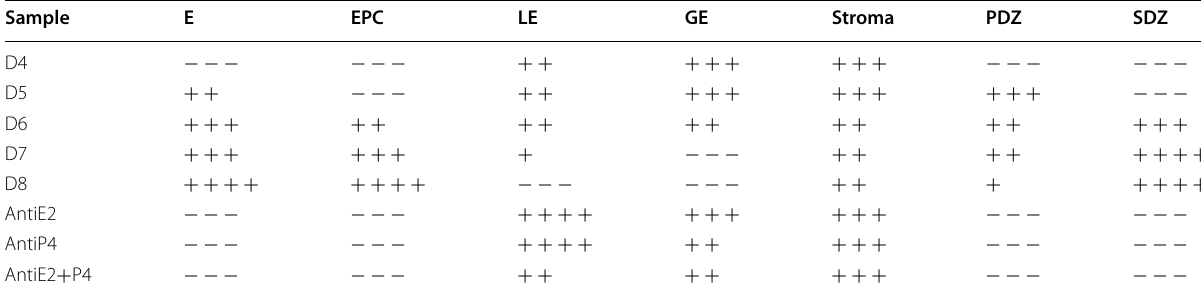
Table 2 Compartment specific expression profile of KLF5 during D4–D8 of gestation and in AntiE2-, AntiP4-, and AntiE2 females. Samples of ovarian steroid antagonist–treated group were collected on the morning of D4. Immunofluorescence signal was quantified in various embryonic and uterine cell types by ImageJ software. Intensity values are expressed as means of observations ( n 5, mean value standard error, P < 0.05). E , embryo, EPC , ectoplacental cone; LE , luminal epithelium, GE , glandular epithelium; PDZ , = ± primary decidual zone; SDZ , secondary decidual